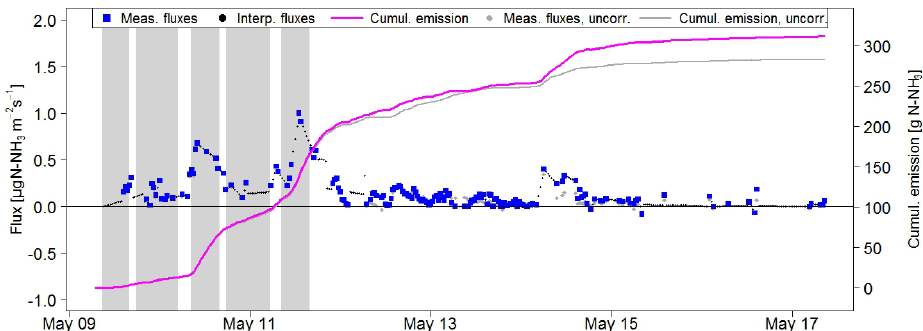
Figure 7. Measured emission of paddocks M.11 and M.12 (between sensors MD2 and MD5; Fig. 1a) during rotation 1. Missing half-hourly flux data were filled based on either linear interpolation or on the default emission curve (Fig. 6) in order to compute the cumulative emissions. For comparison the uncorrected emissions (interference of upwind grazing according to Eq. (4) not considered) are also shown. The shaded time intervals indicate grazing on the investigated paddocks. Table 3. Cumulative emission results for paddocks X .11 and X .12 (combined) of the two pasture systems (M | G ) during the individual rotations. The corresponding averaged weather parameters and N excretion input to the paddocks are also listed. Rotation 4 is not shown due to missing miniDOAS data at the beginning of the rotation.